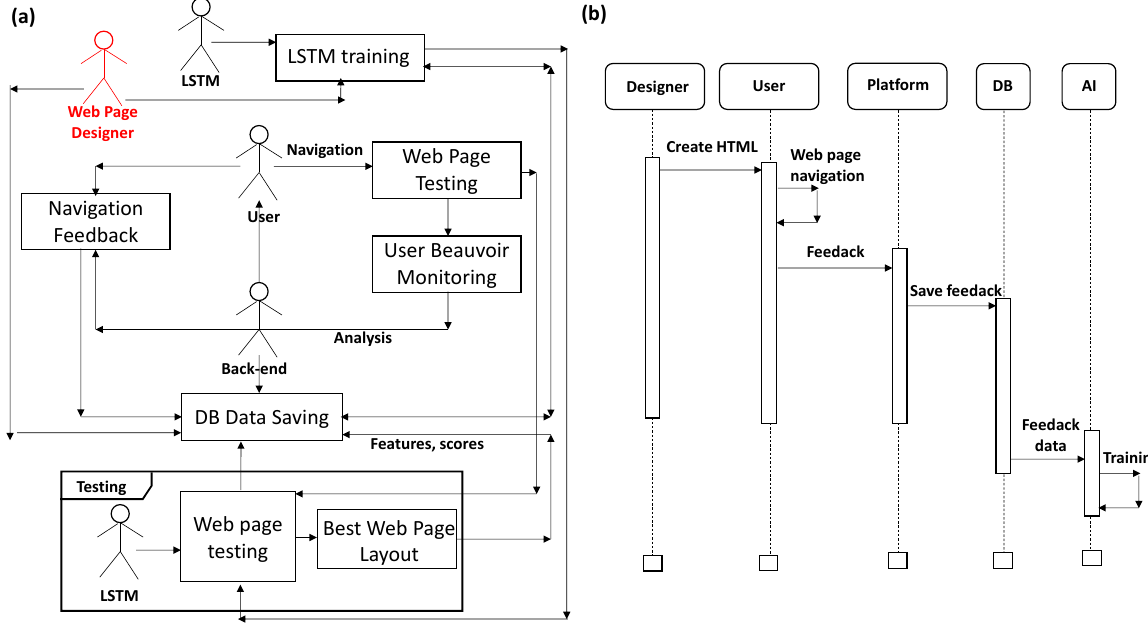
Figure 2. UML diagrams: ( a ) functional diagram representing the main functions of the platform “ ANDUIA ” about automatisms; ( b ) sequence diagram.